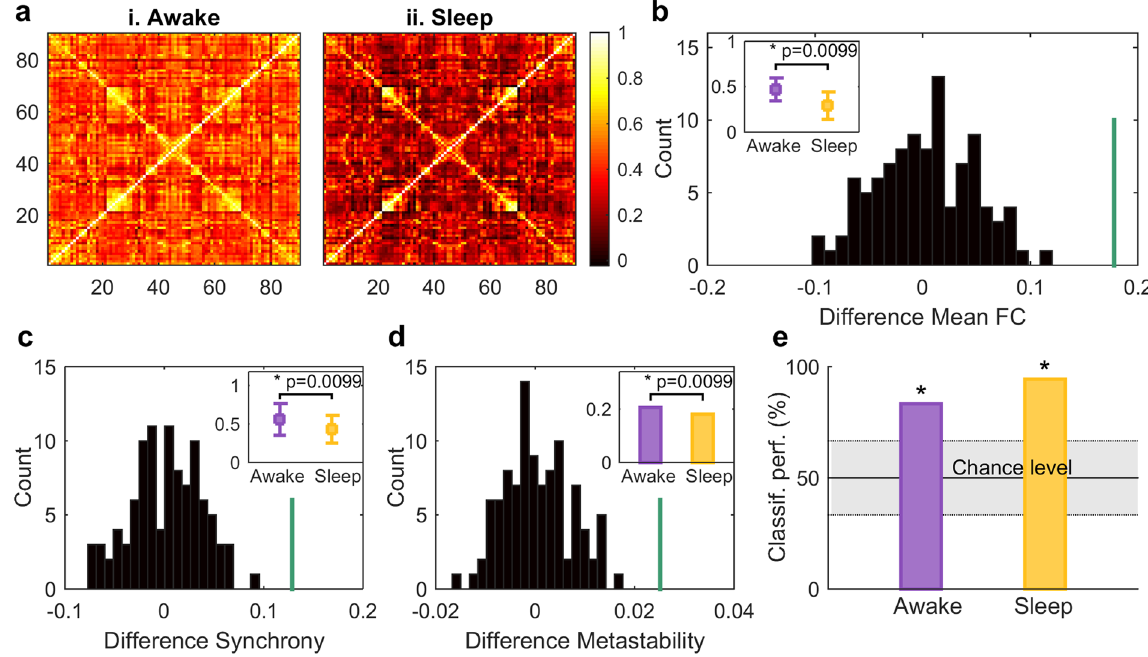
Figure 1. Data Analysis. In ( a ) the functional connectivity matrices averaged over participants are shown for the two different vigilance states. In ( b ) the difference of the mean of the upper triangle FC matrices (group average) between the awake and the sleep state are shown. The histogram (black) represents the distribution of the test-statistic under the null-hypothesis of no difference between vigilance states, whereas the green line shows the difference of the means of the empirical FC matrices. In the upper left corner the mean FCs and their standard deviations are shown. They are significantly different with a p-value of 0.0099. ( c ) demonstrates the difference between the mean synchrony in the awake state and the sleep state. The synchrony is calculated as the mean Kuramoto order parameter (see Methods ). Again, the histogram represents the distribution of the test-statistic and the green line the difference between the synchrony in awake and sleep obtained from the empirical data. In the upper right corner the means and the standard deviations are shown, the mean synchrony is significantly higher in awake than in sleep with a p-value of 0.0099. In ( d ) the difference between the metastability in awake and in sleep is shown. The metastability is calculated as the standard deviation of the Kuramoto order parameter (see Methods ). The histogram and the green line are to be read as in ( b ) and ( c ). In the upper right corner the metastability in awake and in sleep is represented, also in this modality a significant difference (p-value 0.0099) can be observed. In ( e ) the classification performance using a Gaussian classifier is shown for awake (violet) and sleep (yellow) test sets, respectively (see Methods ). The vigilance state is predicted with high accuracy (83.33% and 94.44% for awake and sleep test sets, respectively) exceeding the 95th percentile of chance